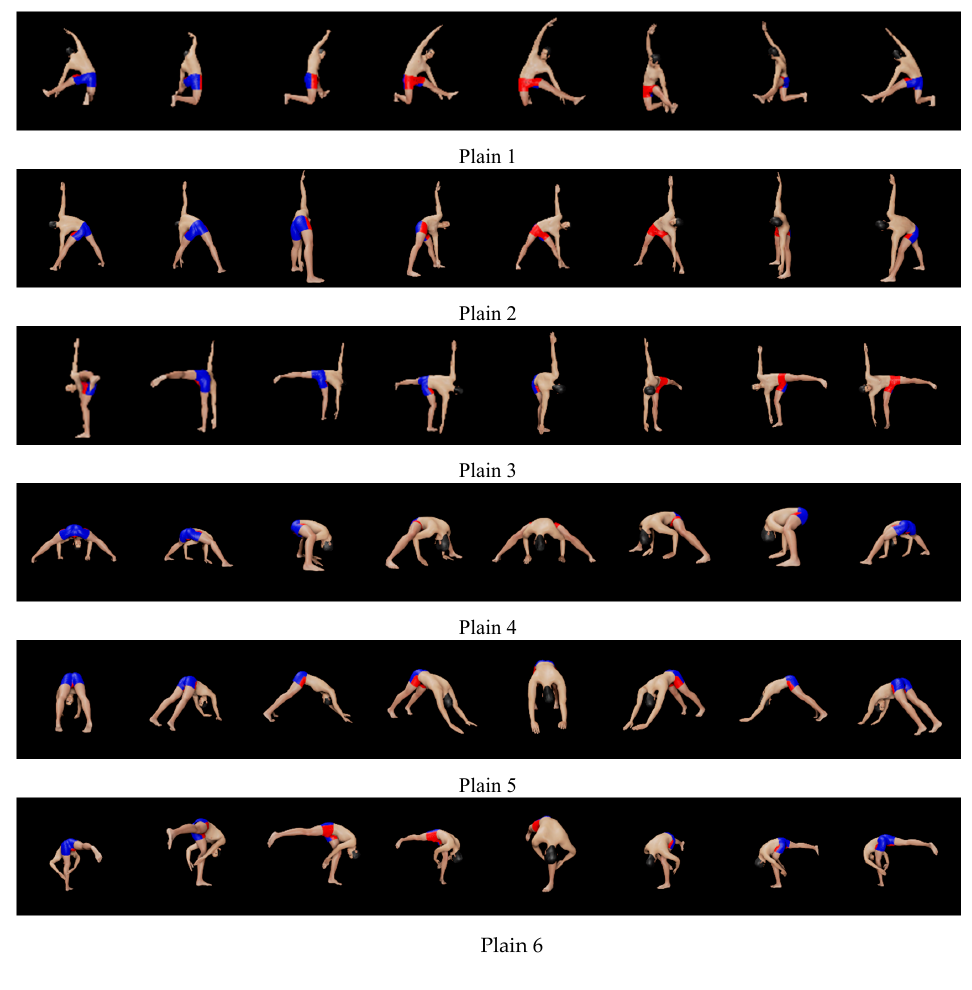
Figure 4. Six plain poses.